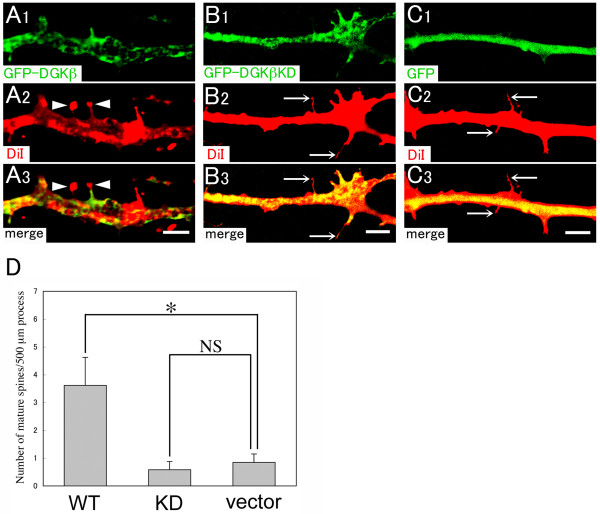
Overexpression of DGKβ in hippocampal neurons at 13 DIV. Cultured neurons were transfected at 13 DIV with GFP-DGKβ (A), GFP-DGKβKD (B), and control vector (GFP) (C). After 24 h incubation, they were fixed and stained with Vybrant-DiI (red) to outline the shape of dendritic spines. Note that mature spines of mushroom-type (A, arrowheads) are frequently observed in neurons transfected with GFP-DGKβ, but hardly with GFP-DGKβKD (B, arrows) and control vector (C, arrows). (D) Histogram showing the density of mature spines per 500 μm dendrite in neurons transfected with GFP-DGKβ (n = 5 neurons), GFP-DGKβKD (n = 7 neurons), and control vector (n = 6 neurons). The data are the mean ± S.E.M. *P < 0.05; NS, statistically not significant. Scale bars, 5 μm.